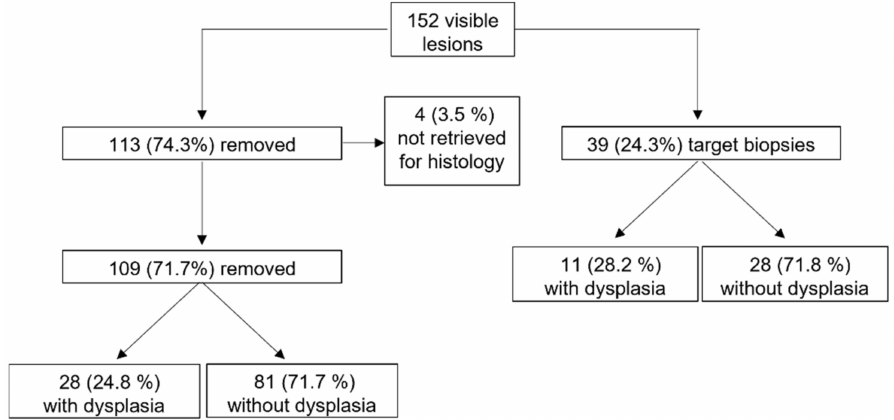
Figure 2. Management and histological assessment of the lesions found during DCE.